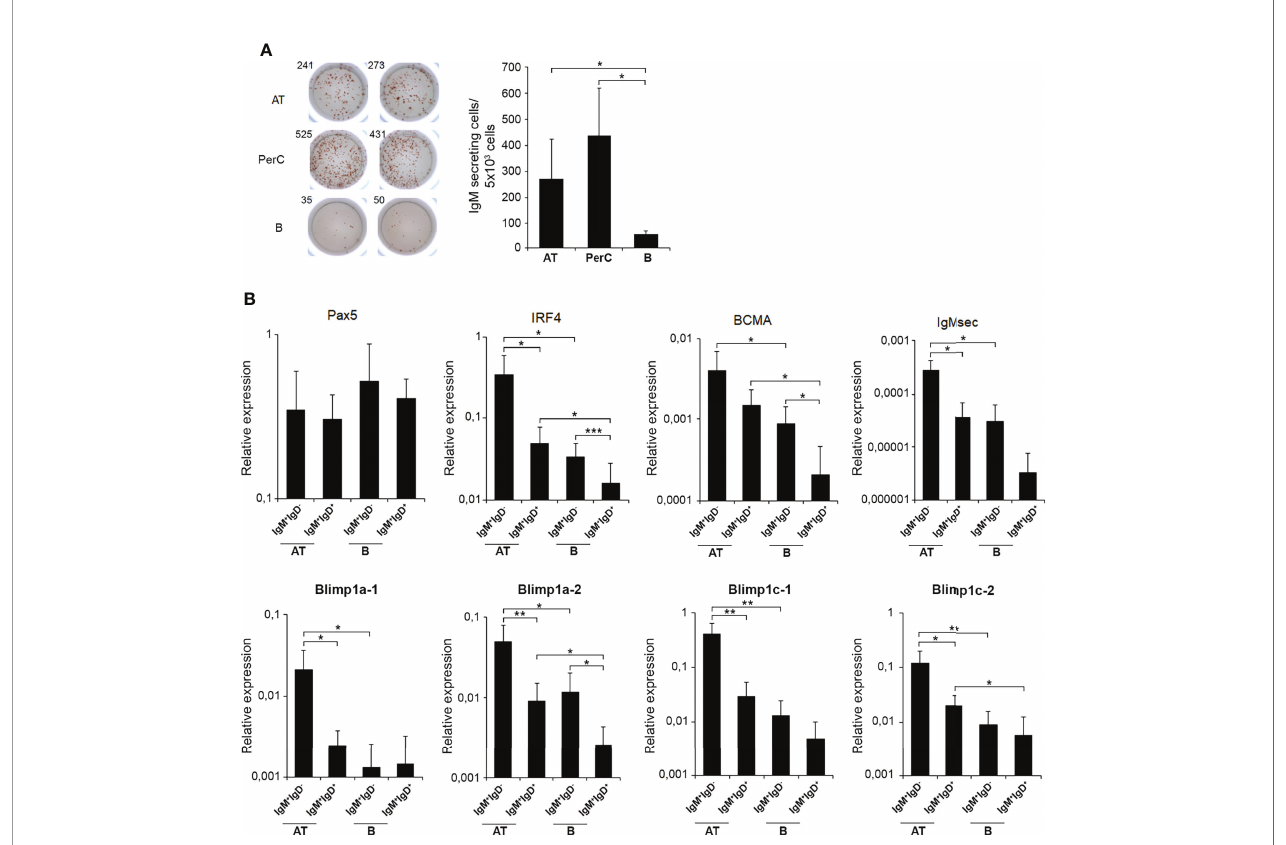
FIGURE 4 | ELISPOT analysis of IgM-secreting cells in rainbow trout AT, peritoneal cavity and blood and transcriptional analysis of IgM + sorted B cells from AT and blood. (A) Isolated leukocytes from rainbow trout AT, peritoneal cavity (PerC) and blood were plated in ELISPOT plates, previously coated with anti-IgM mAb for 24 h. After incubation, cells were washed away and a biotinylated anti-IgM mAb used to detect number of spot forming cells. Duplicates for a representative individual (left) in each tissue and quanti fi cation of spot forming cells (right) from 6 independent fi sh are shown (mean + SD). Asterisks denote signi fi cantly different values among groups as indicated (*p ≤ 0.05). (B) AT and blood IgM + IgD + and IgM + IgD - B cell subpopulations were FACS isolated and the transcription levels of different genes associated with B cell differentiation studied by real time PCR. Results are shown as relative expression values to endogenous control EF-1 a (mean + SD; n =7 fi sh). Asterisks denote signi fi cantly different values between the indicated groups (*p ≤ 0.05; **p ≤ 0.01 and ***p ≤